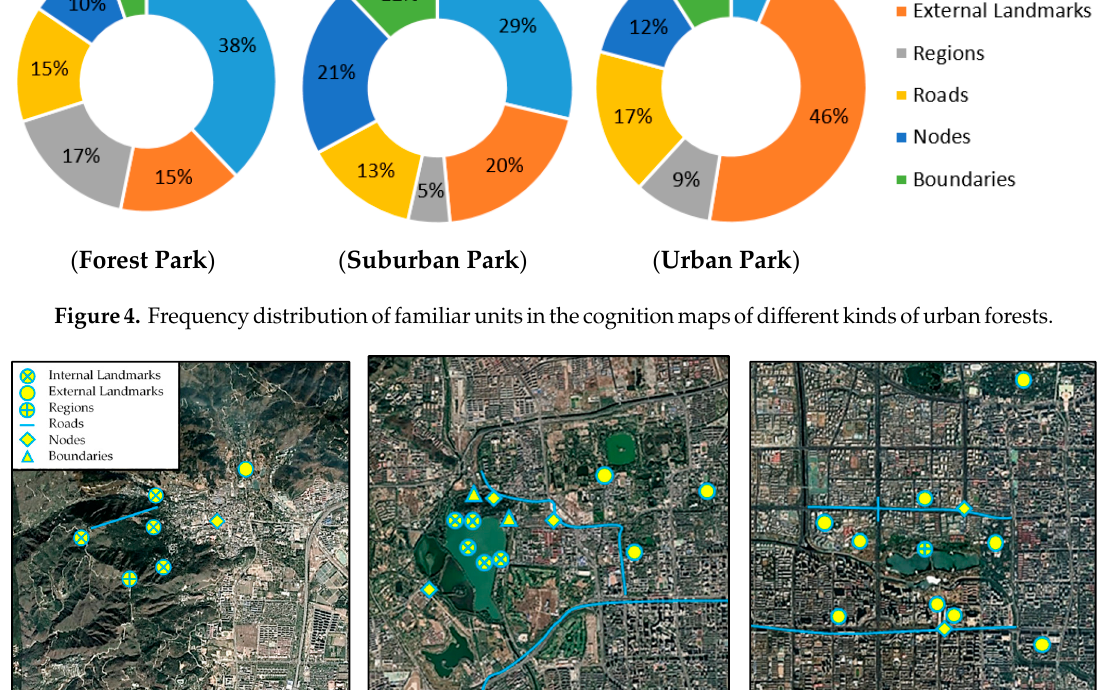
Figure 4. Frequency distribution of familiar units in the cognition maps of different kinds of urban forests.